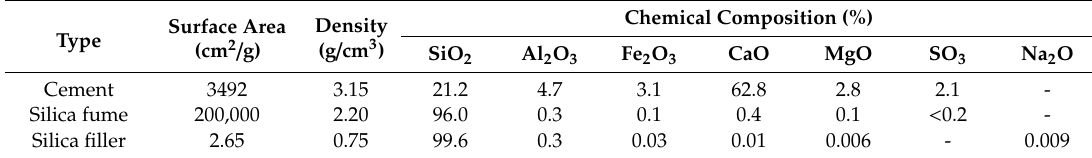
Table 3. Chemical compositions and physical properties of materials.